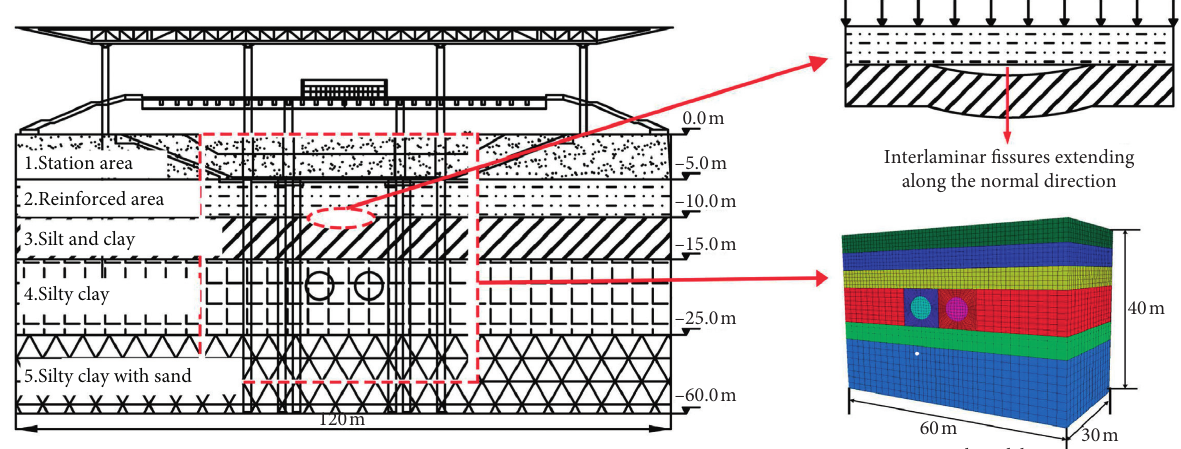
Figure 5: Interlaminar fissures.